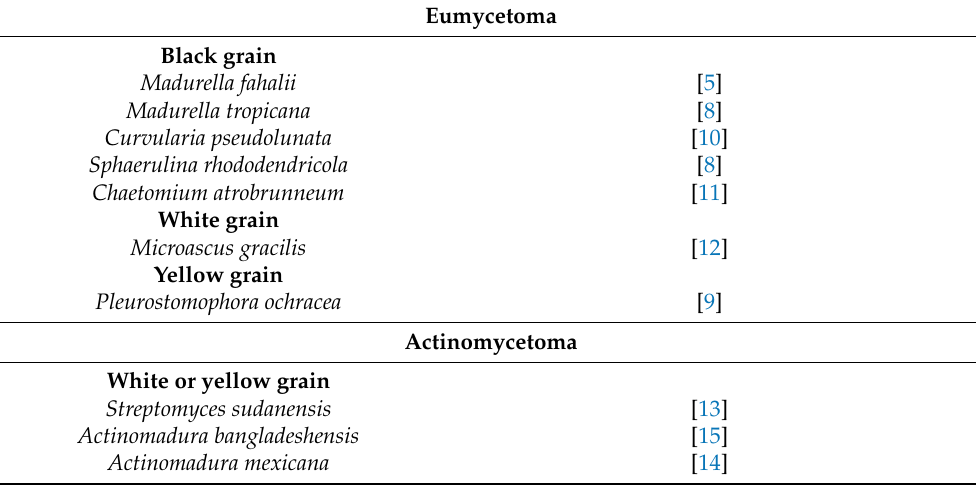
Table 1. Newly identified causative agents of mycetoma in Africa